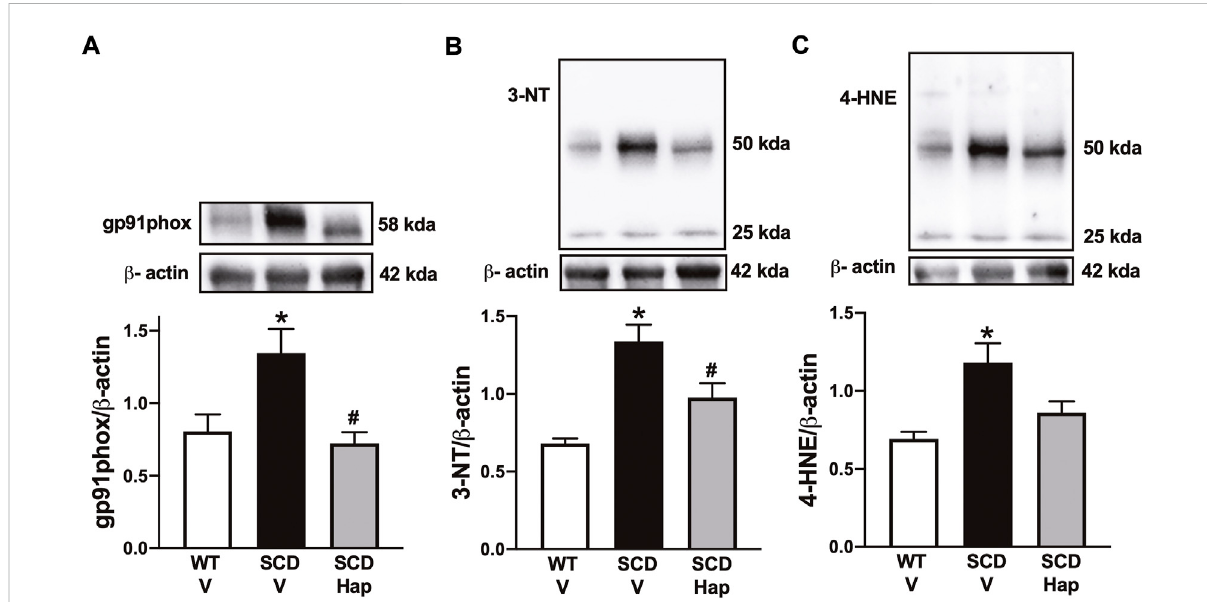
FIGURE 6 Representative images of western blotting (top panels) and protein values (bottom panels) for gp91 phox (A) , 3-NT (B) , and 4-HNE (C) in homogenatesofpenisesfromWTandSCDmicetreatedornotwithhaptoglobin.Datarepresentthemean±S.E.M.for6miceineachgroup.Asingle band for gp91phox, 3-NT and 4-HNE was normalized to β -actin. * p < 0.05 vs. WT-Vehicle; # p < 0.05 vs. SCD-Hap.